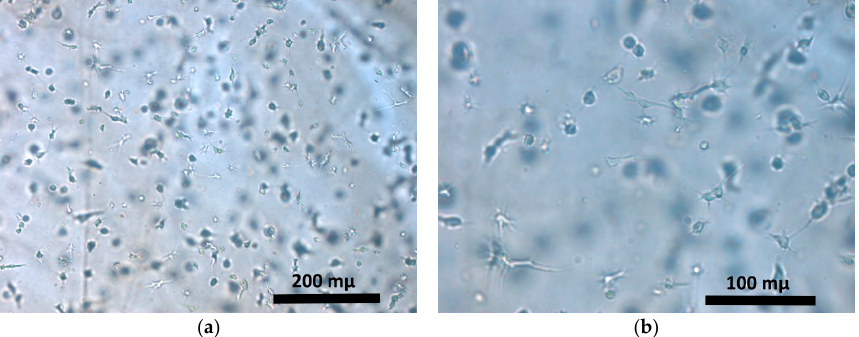
Figure 1. ASCs in the sca ff old structure after 72 h of cultivation: ( a ) objective lens 10 × , eye-. piece 10 × , light microscopy, ( b ) objective lens 20 × , eyepiece 10 × light